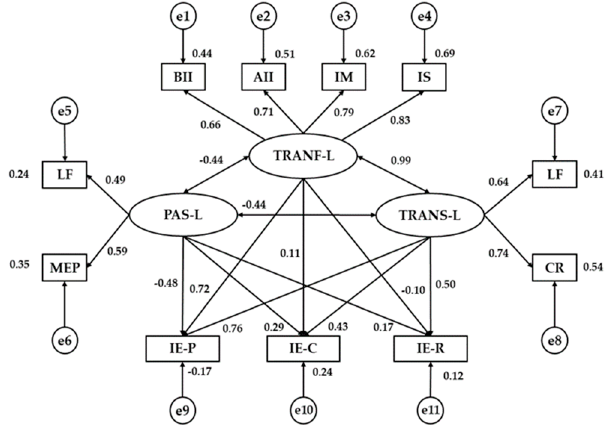
Figure 3. Structural equation model for university teaching. Note1: TRANF-L, Transformational Leadership; TRANS-L, Transactional Leadership; PAS-L, Passive Leadership; BII, Behavioral Idealized Influence; AII, Attributed Idealized Influence; IM, Inspired Motivation; IS, Intellectual Stimulation; IC, Individualized Consideration; CR, Contingent Reward; MEP, Management-by-Exception Passive; LF, Laissez-Faire; IE-P, Emotional Intelligence Perception; IE-U, Emotional Intelligence Understanding; IE-R, Emotional Intelligence